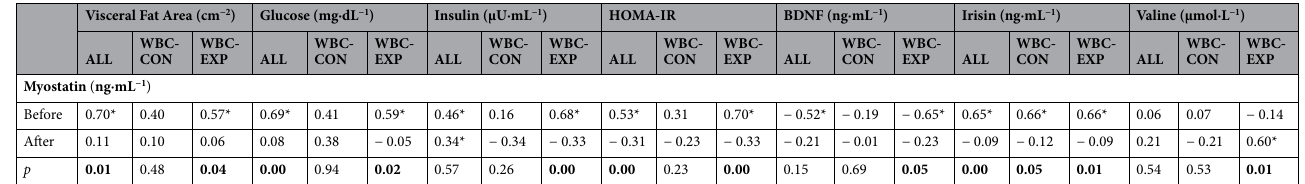
Table 1. Correlation coefficients of myostatin and visceral fat area; glucose; insulin; HOMA-IR; BDNF; irisin and valine among ALL participants: WBC-CON and WBC-EXP group recorded before and after whole procedure. Values are Spearman correlation; *statistically significant correlations; p- difference between the correlations; p < 0.05; Statistically significant differences between correlations are bold.